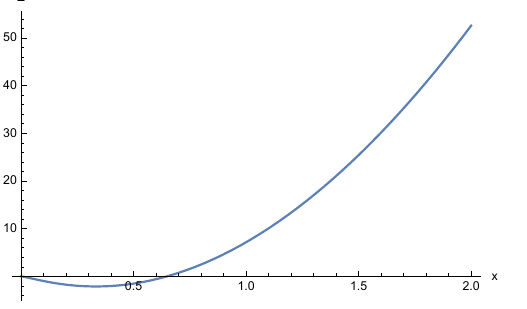
Figure 1. m = M = G = k B = 1, and x = 1/ T . Plot of Z ( x ) . Here, x = β , G = m = M = 1. For small x , we see that Z is negative. These x -values are, of course, unphysical. Z grows as T diminishes.